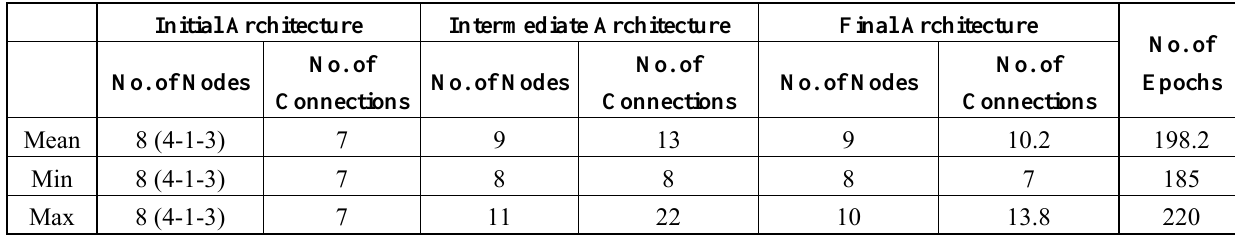
Table 4. ANN architectures and the training epochs for the irish dataset.